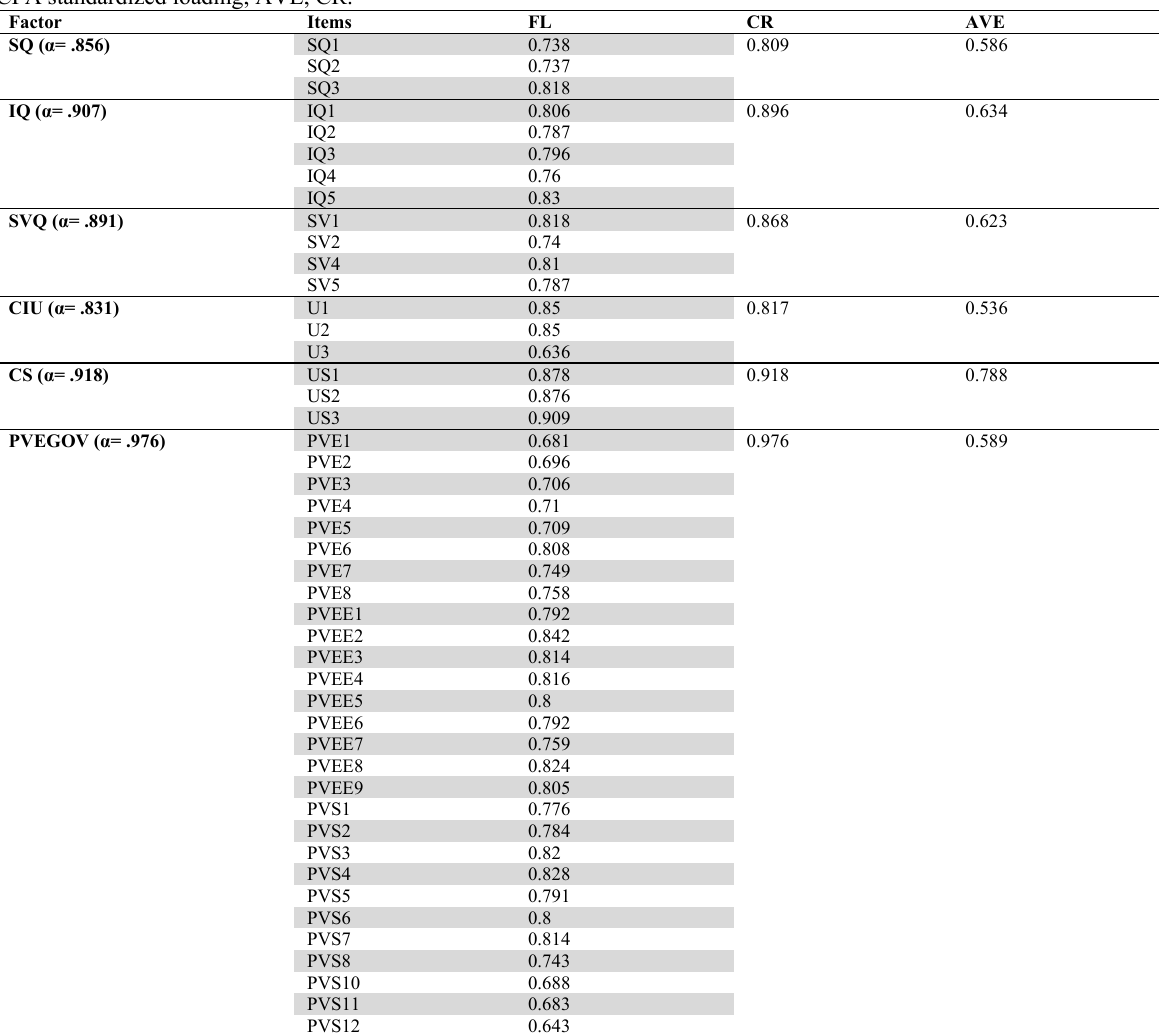
CFA standardized loading, AVE,